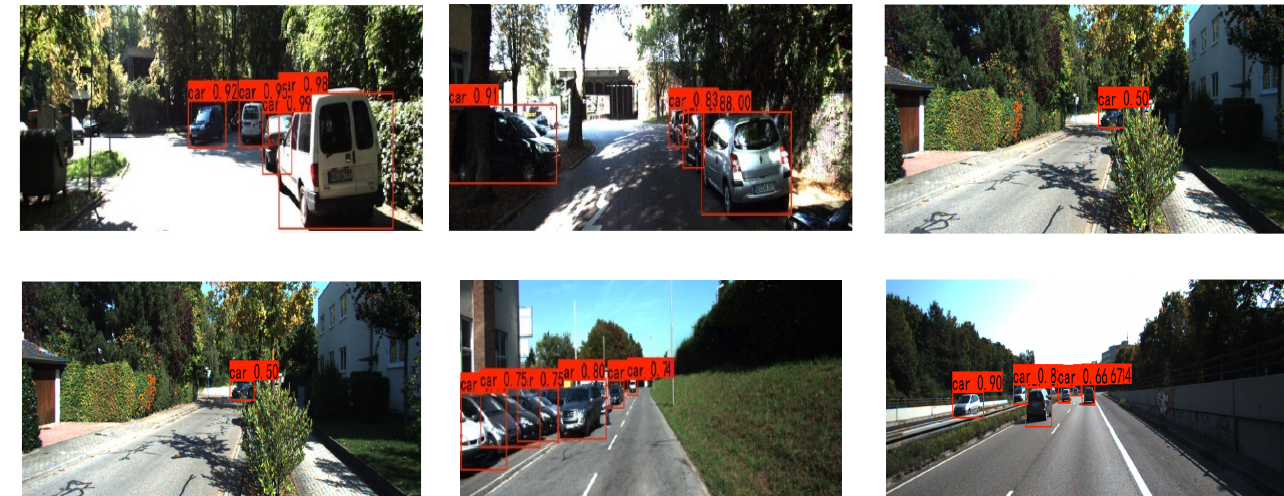
Figure 9. YOLOv5 detection results.